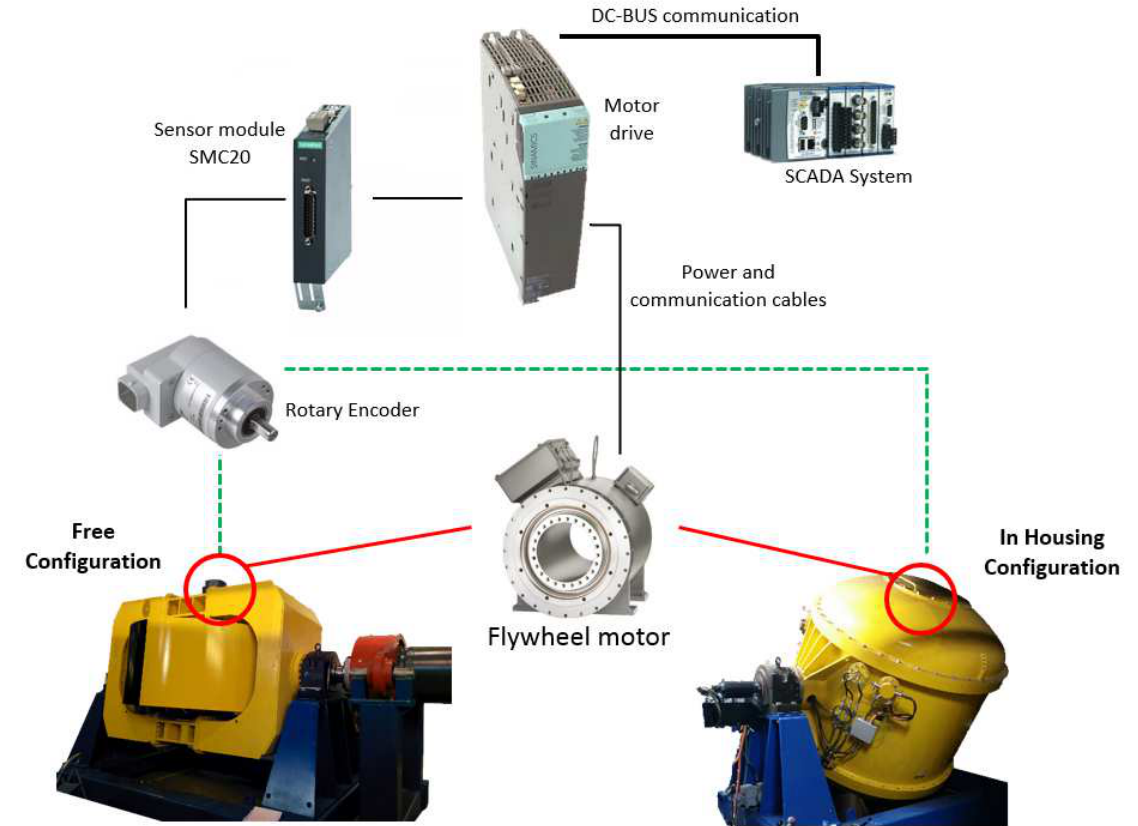
Figure 10. Layout of the test rig with the main